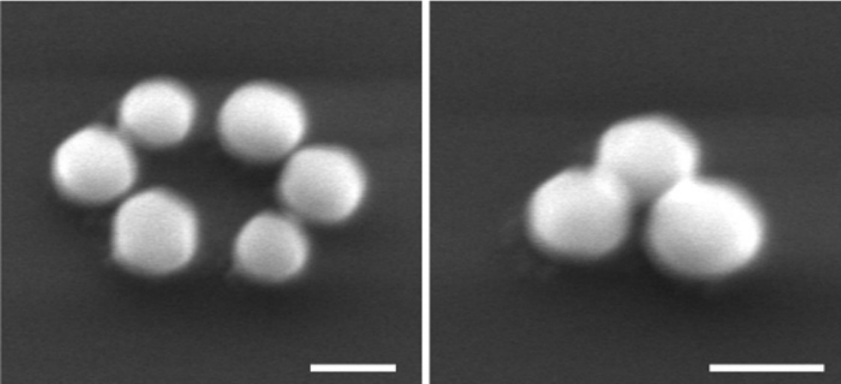
Figure 3: Examples of nano-oligomer structures that were fabricated with the method described in the text. The scale bar is 100 nm in both SEM images, which were taken at an angle of 45 ° .